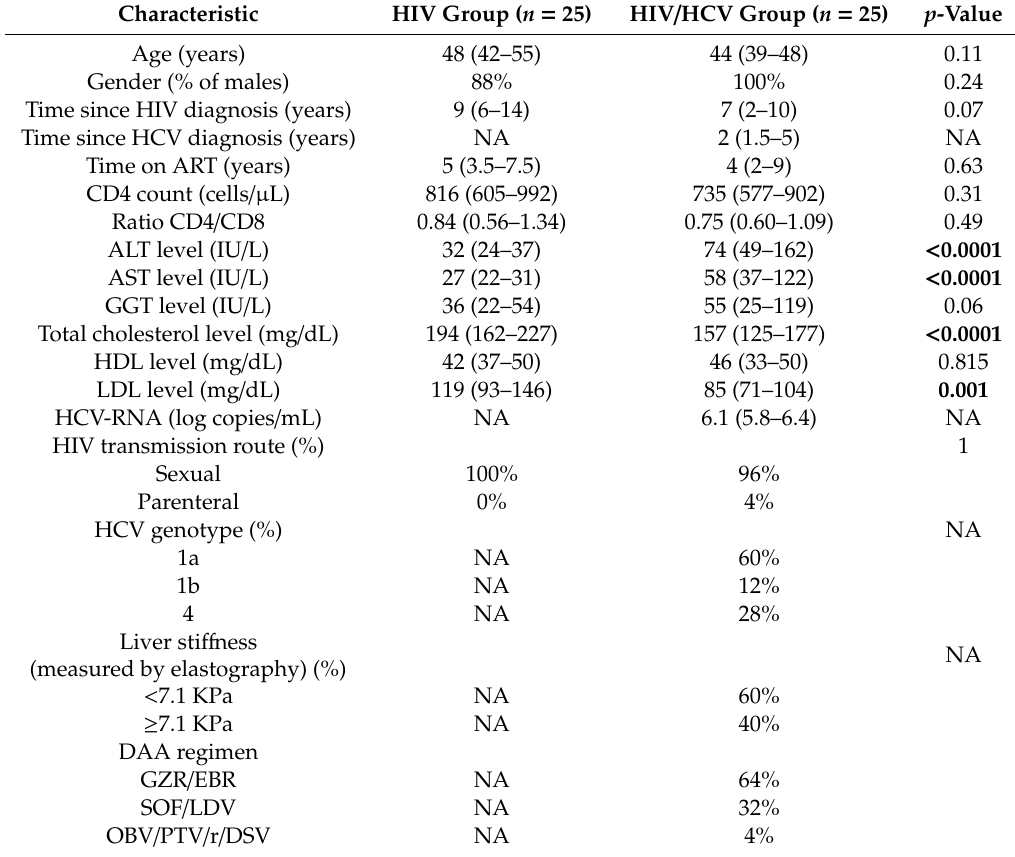
Table 1. Characteristics at baseline of patients included in the